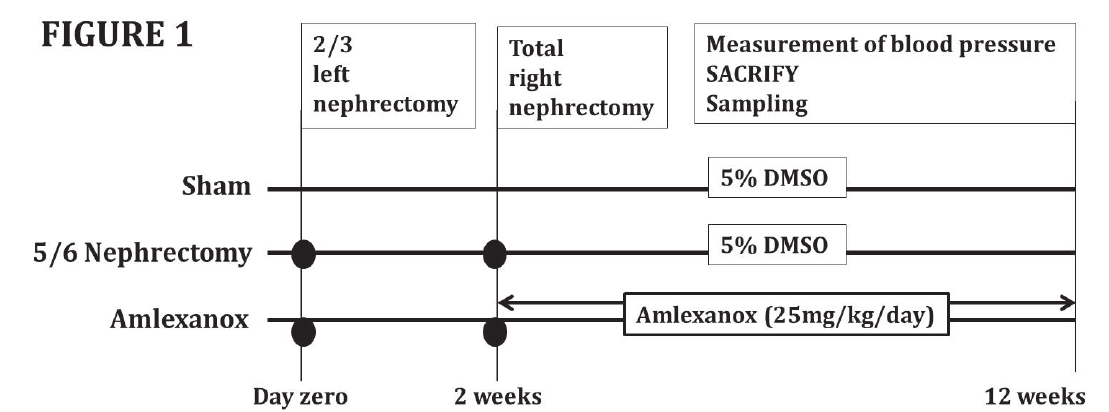
FIGURE 1 - Experimental